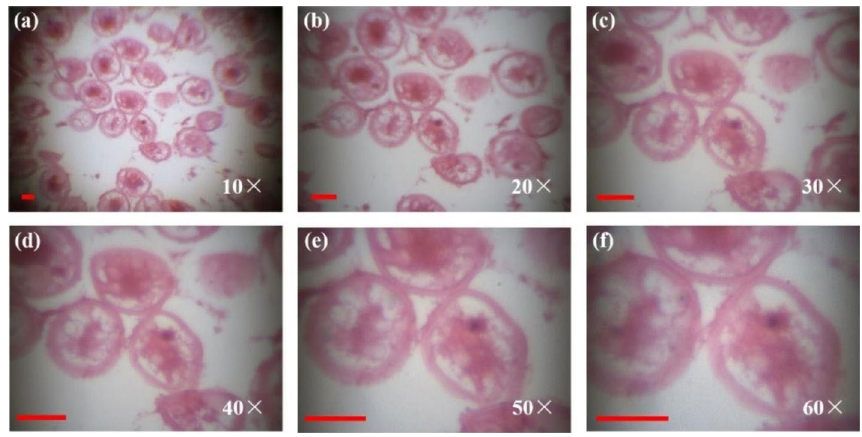
Fig. 9 Captured images of the sample “ascaris ovaries”. (a) Magnification 10 × . (b) Magnification 20 × . (c) Magnifica- tion 30 × . (d) Magnification 40 × . (e) Magnification 50 × . (e) Magnification 60 × . The scale bars in these pictures are 20